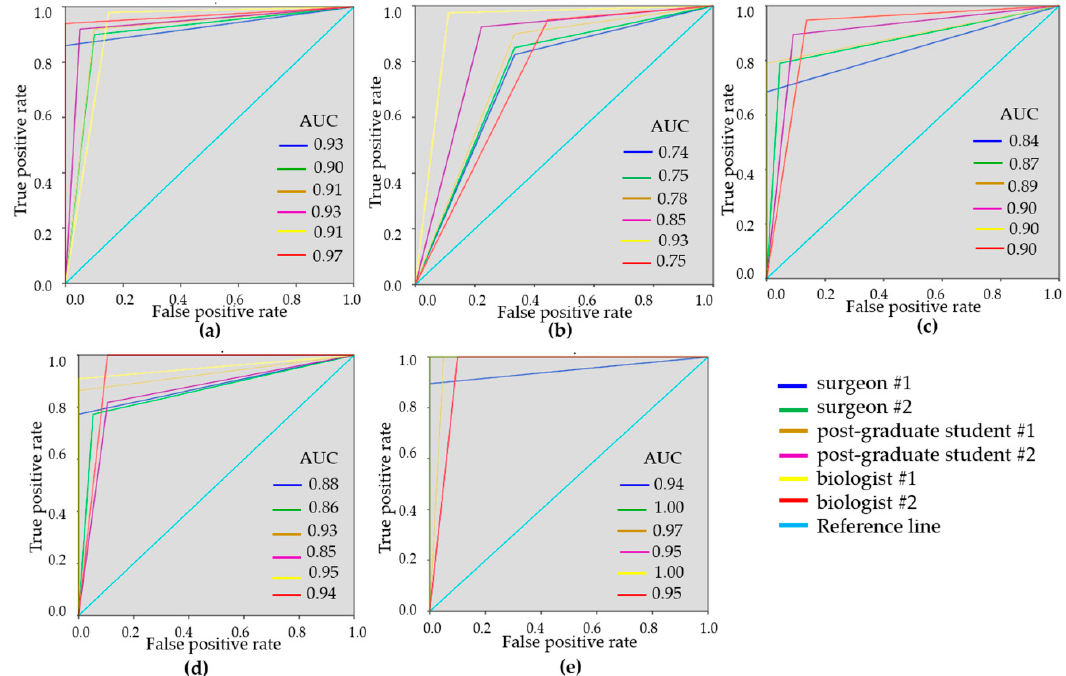
Figure 3. Receiver operating characteristic (ROC)-curves showing the results of visual assessment CP-OCT images for distinguishing non-tumorous breast tissue from tumor ( a ), DCIS from invasive breast cancer ( b ), low-aggressive invasive breast cancer from highly aggressive ( c ), non-tumorous breast tissue from low-aggressive breast cancer ( d ), non-tumorous breast tissue from highly aggressive breast cancer ( e ) for six “blinded” readers.